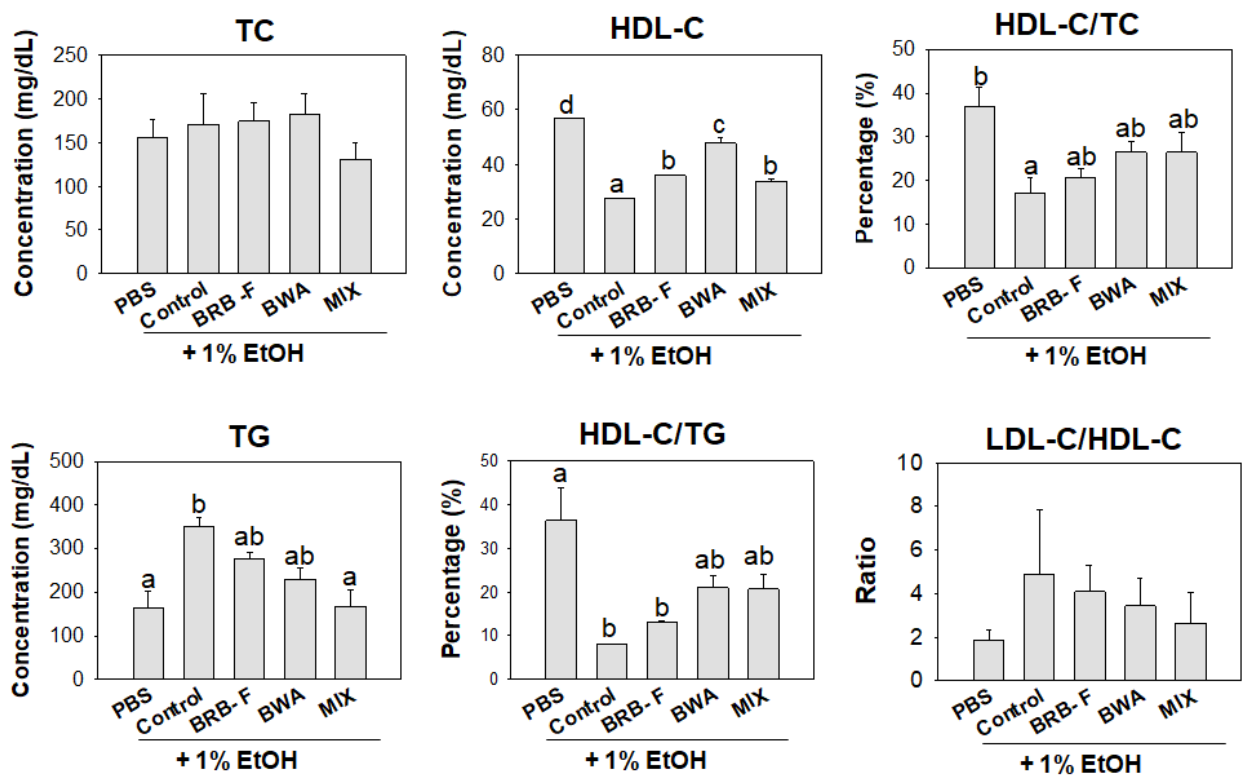
Figure 7. Effect of BRB-F, BWA, and MIX in alcohol liver injury zebrafish for 10 days on the plasma lipid profile. Data are mean ± SEM; a,b,c,d mean values with different superscript letters are signifi- cantly different among the groups ( p < 0.05). PBS, zebrafish exposed to 1% PBS, n = 20; EtOH, zebrafish exposed to 1% ethanol, n = 20; BRB-F, EtOH fed 10% black rice bran, n = 20; BWA, EtOH fed 10% beeswax alcohol, n = 20; MIX, EtOH fed a mixture of BWA and BRB-F(1:6, w / w ), n = 20; TC, total cholesterol; HDL-C, high-density lipoprotein cholesterol; TG, triglyceride; LDL-C, low-density lipoprotein cholesterol.